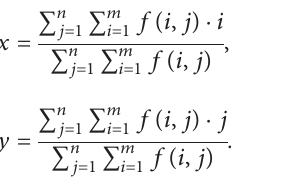
Figure 8: The position of the centroid of the artificial target is affected by the selection of the area.